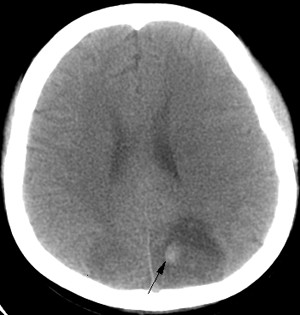
CT of a 19 year-old SLE patient who presented with coma. CT image on brain show showing bilateral hypodensities involving gray and white matter in posterior circulation territories as well as a right occipital hematoma (arrow).